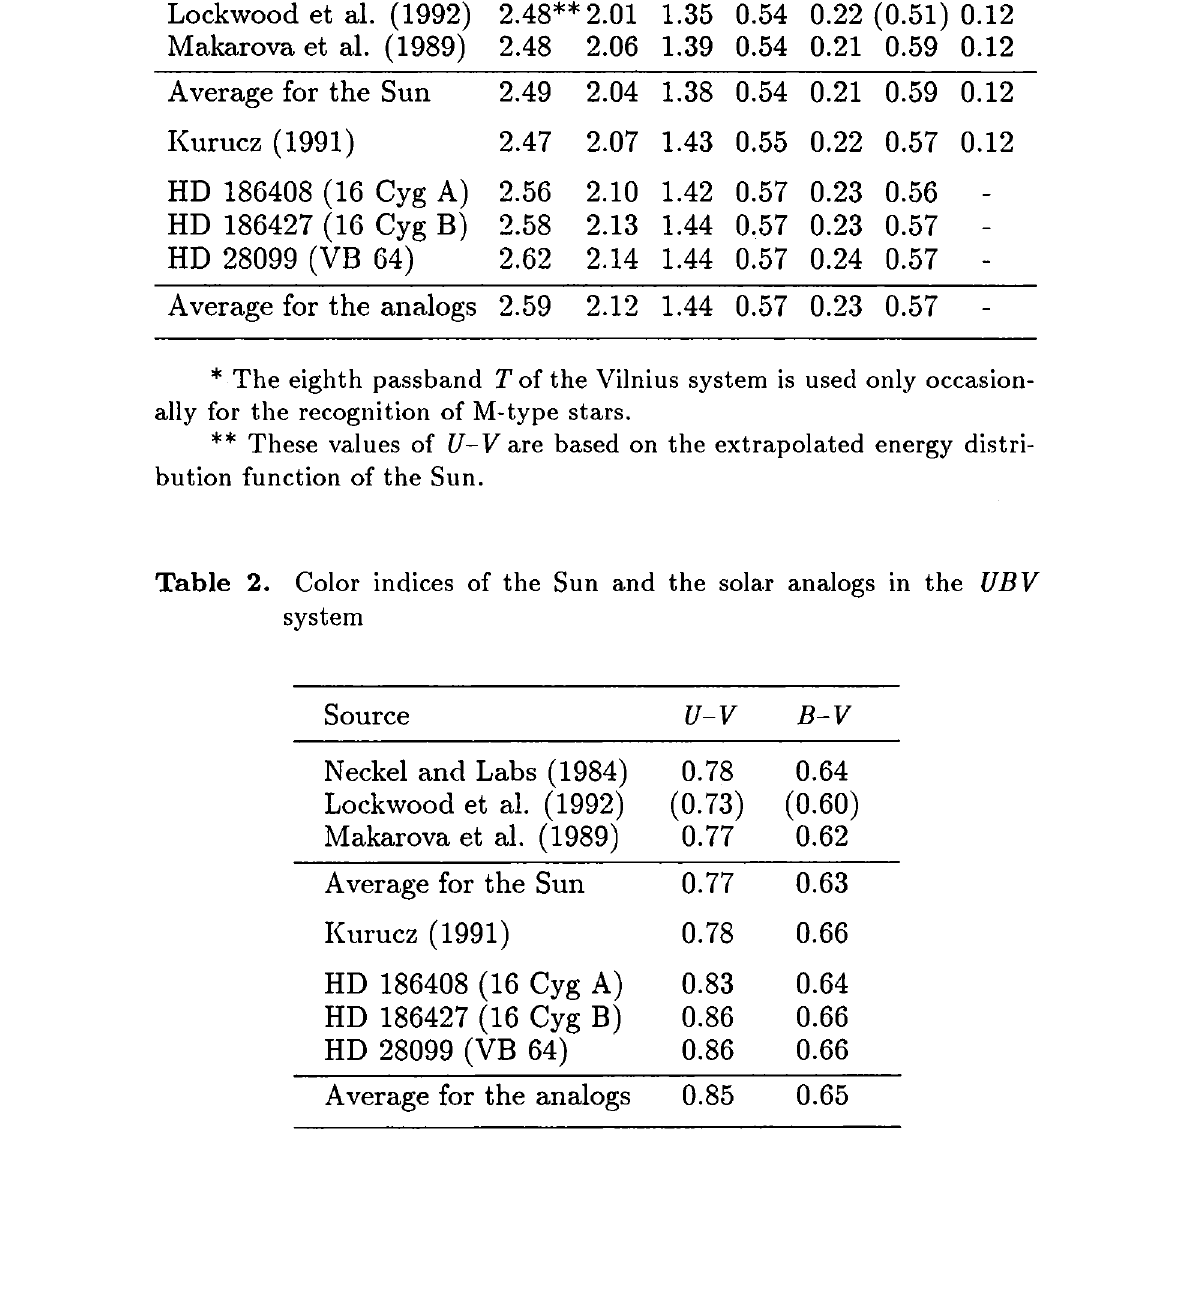
Table 1. Color indices of the Sun and the solar analogs in the Vilnius system.